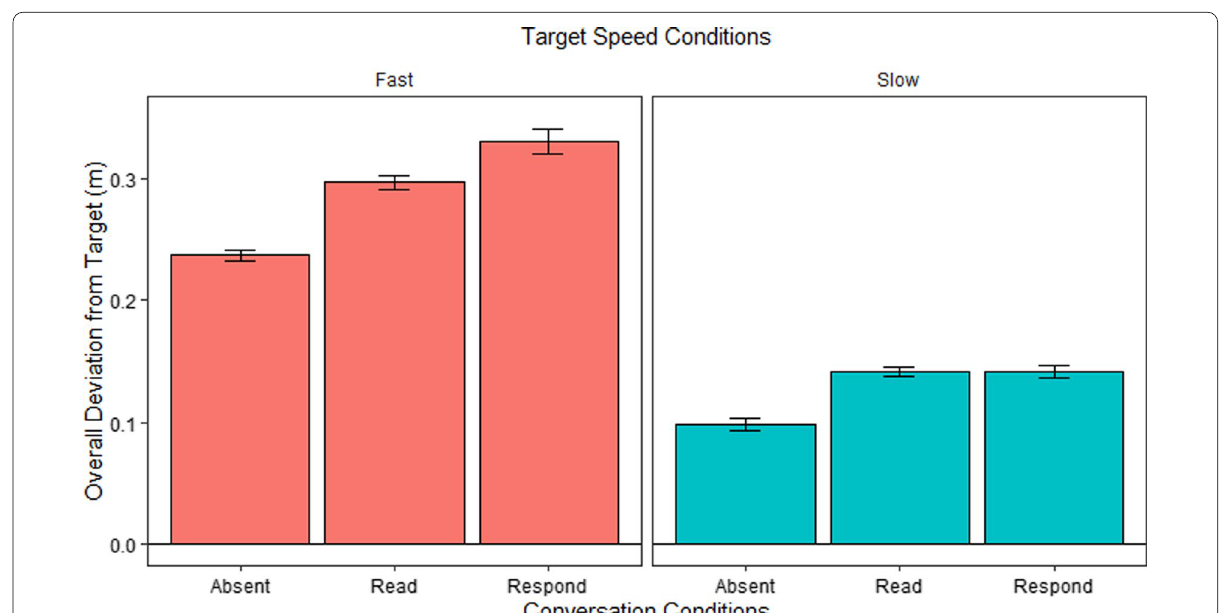
Fig. 7 Overall deviation from target during different conversation conditions in Fast and Slow speed conditions in E2. Error bars show the SEM. Note that for graphical clarity, the scales of this figure are different than those used in Fig.